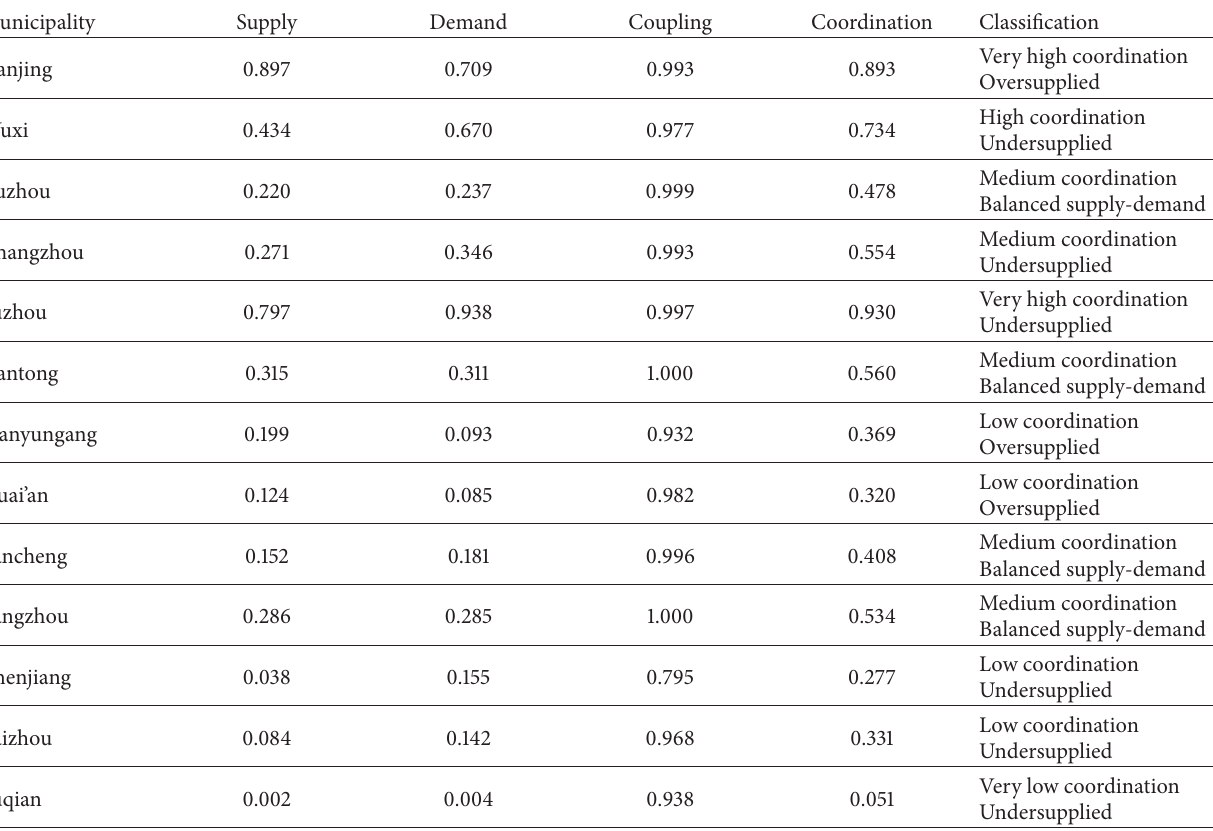
Table 4: Degrees of coordination and supply-demand balances for municipalities of Jiangsu province.